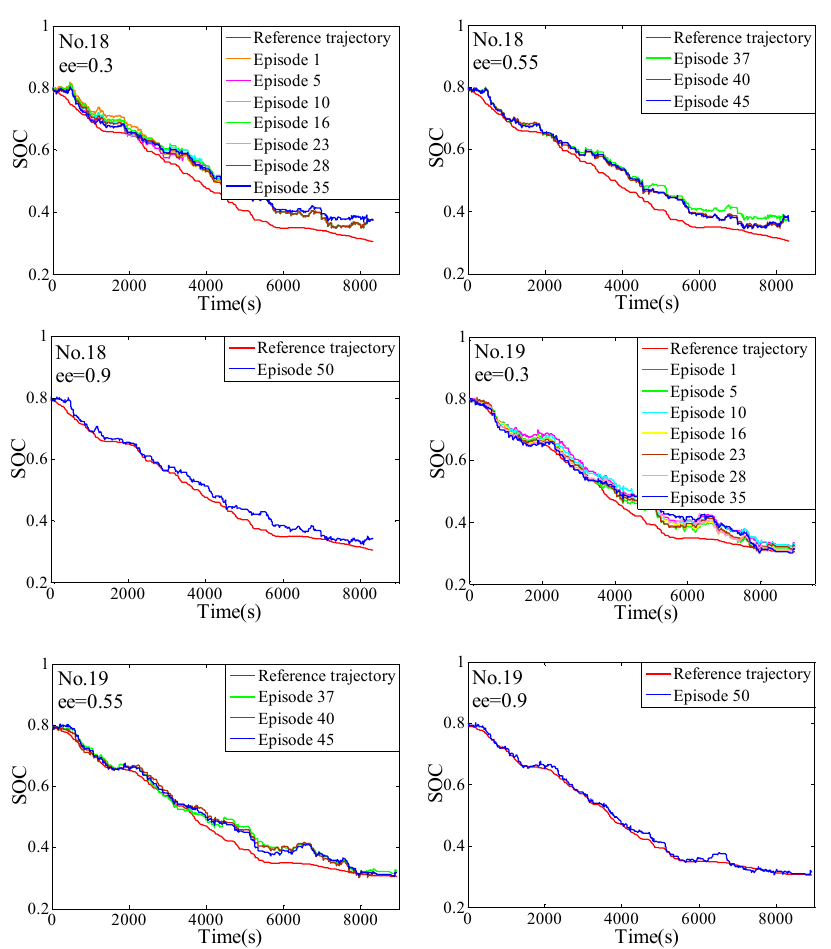
Figure 17. The training process of combined driving cycle 18 and 19.